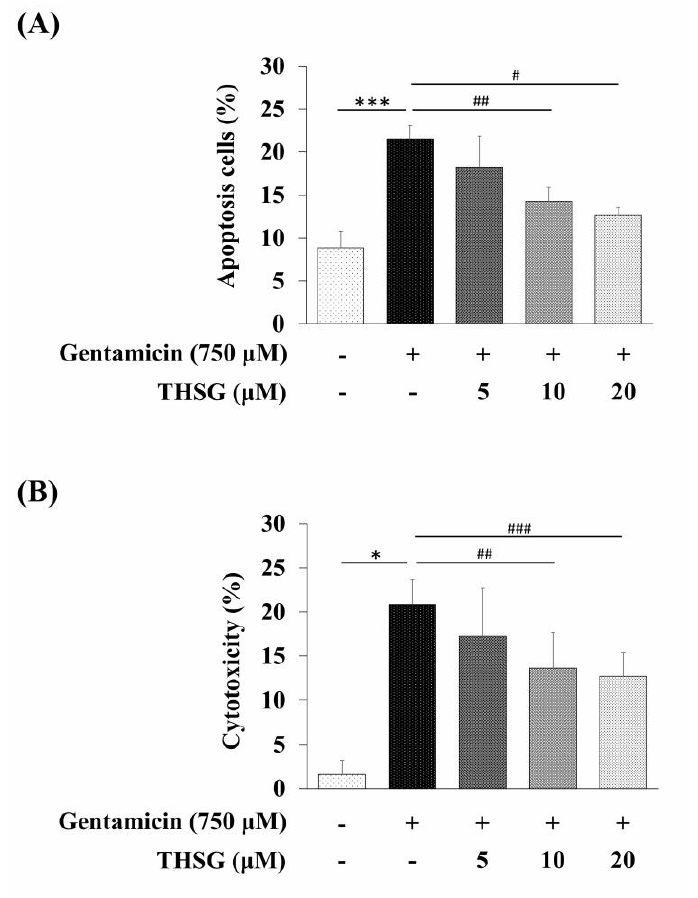
Figure 5. Effects of THSG on gentamicin-induced apoptosis and cytotoxicity in mouse cochlear UB/OC-2 cells. Cells were treated with various THSG concentrations for 6 h, followed by 750 μM gentamicin for 24 h. ( A ) The percentage of apoptotic cells was detected by Annexin V and propidium iodide (PI) staining. ( B ) Cytotoxicity was monitored by measuring LDH release. All data are expressed as the means ± standard deviation from three independent experiments. * p < 0.05, *** p < 0.001 vs. the control group; # p < 0.05, ## p < 0.01, ### p < 0.001 vs. the gentamicin-treated group.